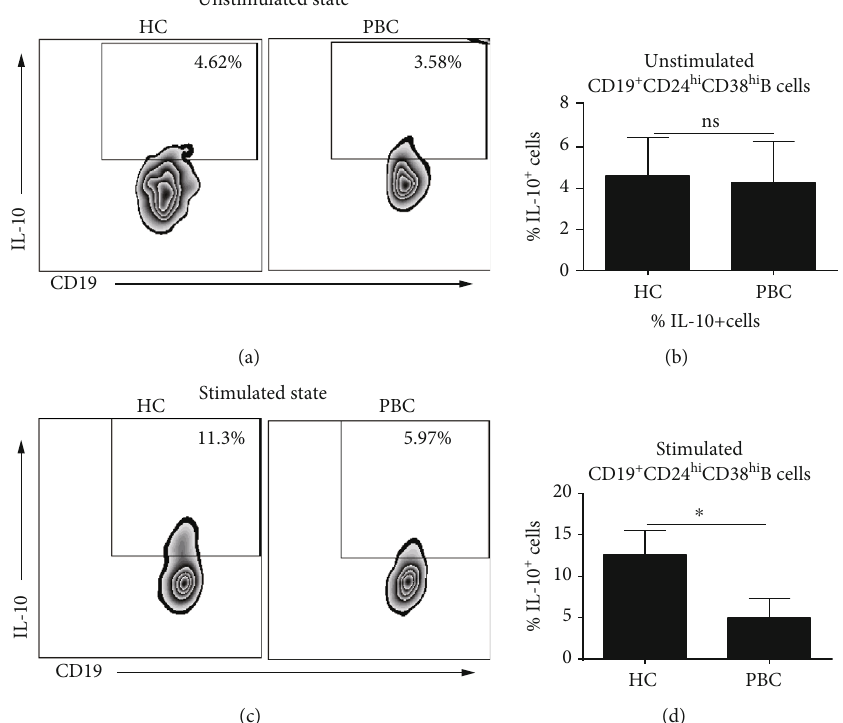
Figure 4: CD19 + CD24 hi CD38 hi B cells from PBC patients express lower level of IL-10 when stimulated by anti-BCR and CpG, compared to HC subjects. PBMC from PBC and healthy individuals were stimulated for 48 h with or without anti-BCR and CpG. Phorbol ester, plus ionomycin, plus Brefeldin A were added for the last 5 h of culture. Cells were surface stained with CD19, CD24, and CD38 monoclonal antibodies (mAbs) and intracellularly stained for IL-10. (a, c) Representative intracellular IL-10 staining in unstimulated or stimulated CD19 + CD24 hi CD38 hi B cells in the peripheral blood of one PBC patient and healthy control. (b, d) Statistical graph of the frequency of IL-10 + cells in unstimulated or stimulated CD19 + CD24 hi CD38 hi B cells from PBC patients and HC subjects; ∗ P < 0 : 05